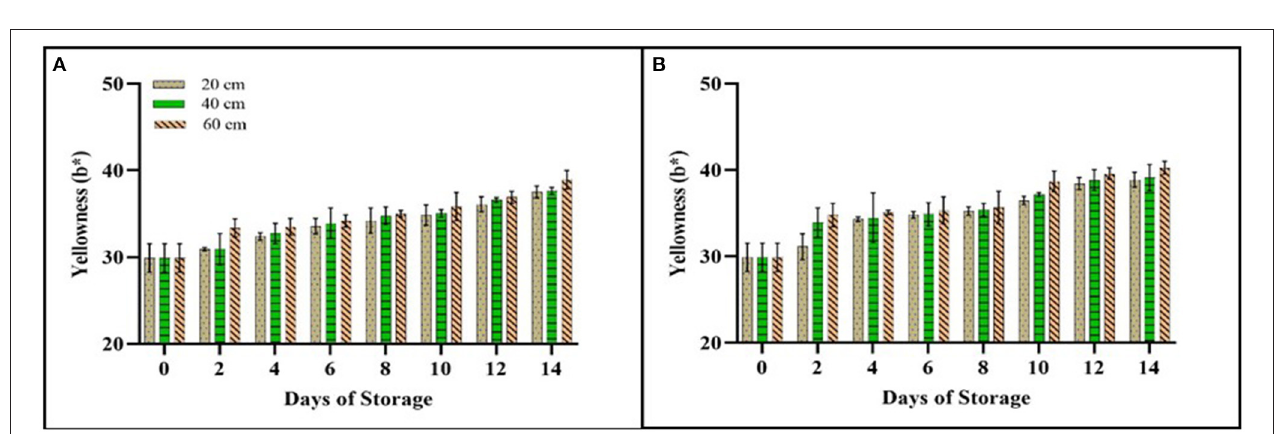
FIGURE 7 | b* value of pear impacted at different drop heights (20, 40, and 60cm) during 14 days at (A) 10 ◦ C and (B) 22 ◦ C storage conditions. The data were expressed in mean ± standard deviation. Error bars represent the standard deviation (S.D.) of the mean values ± S.D. of 18 readings per three replicates.